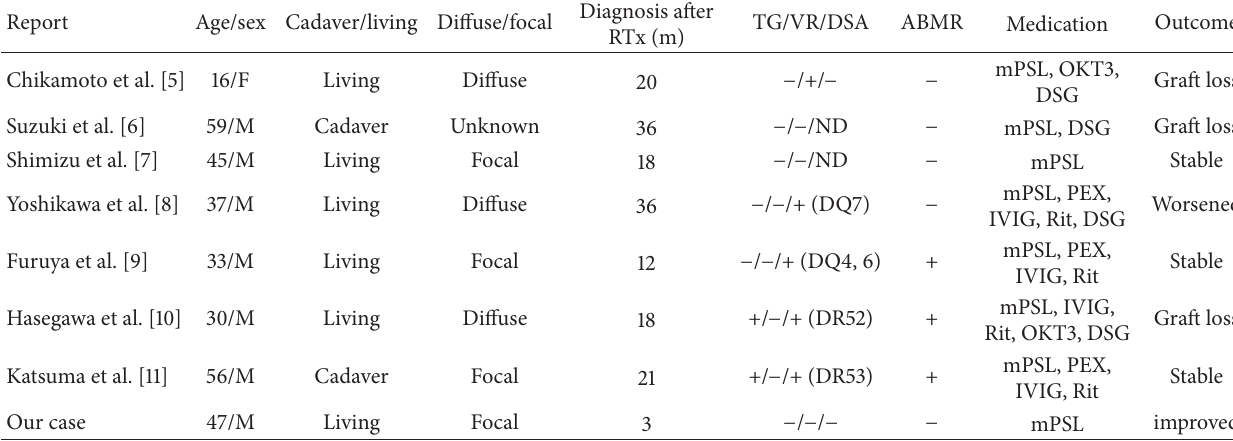
Table 1: Previous case reports of plasma cell rich acute